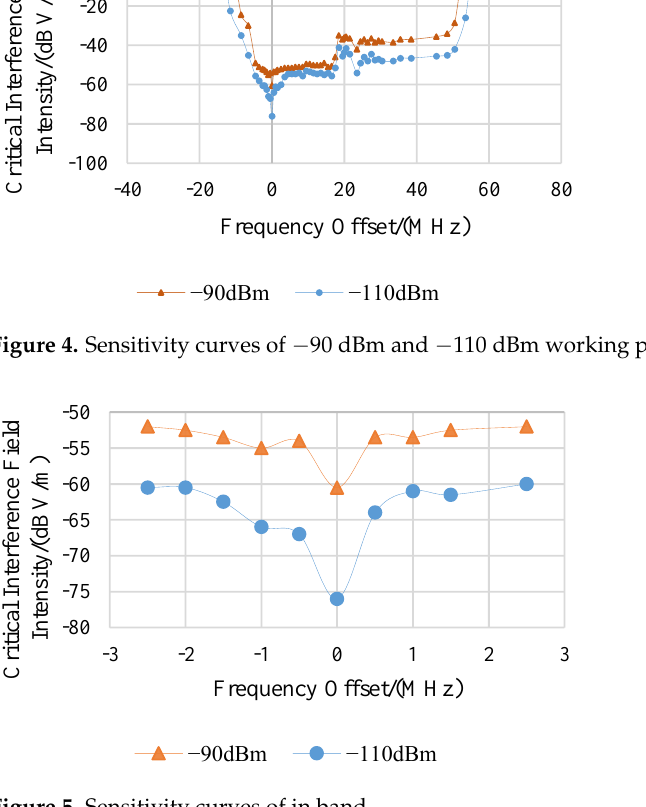
Figure 5. Sensitivity curves of in band.